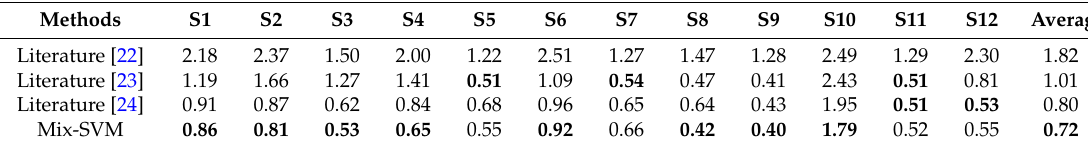
Table 2. The AAEP on the 12 datasets. The unit is